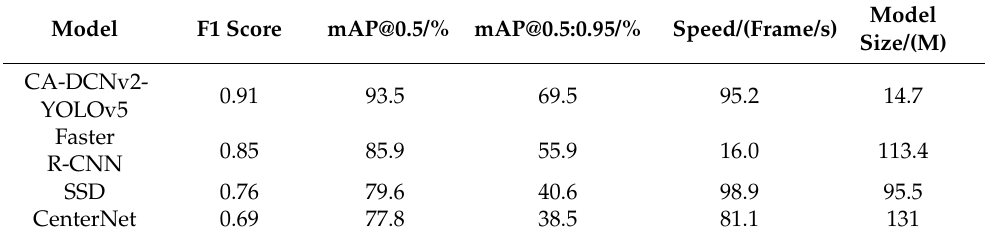
Table 4. Performance comparison of different